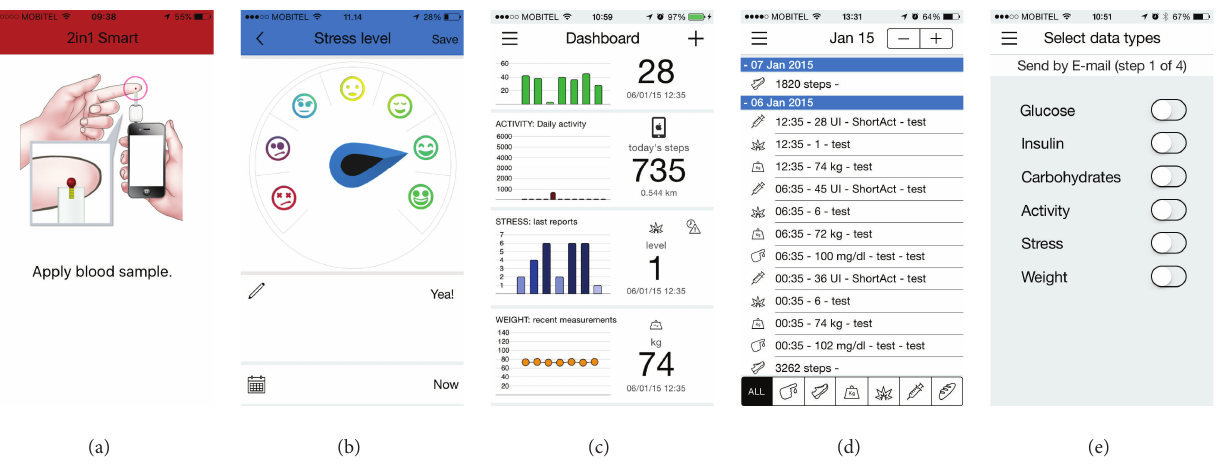
Figure 3: (a) Measuring glucose with the device, (b) assessing stress level, (c) chart overview, (d) logbook, and (e) sending observations by